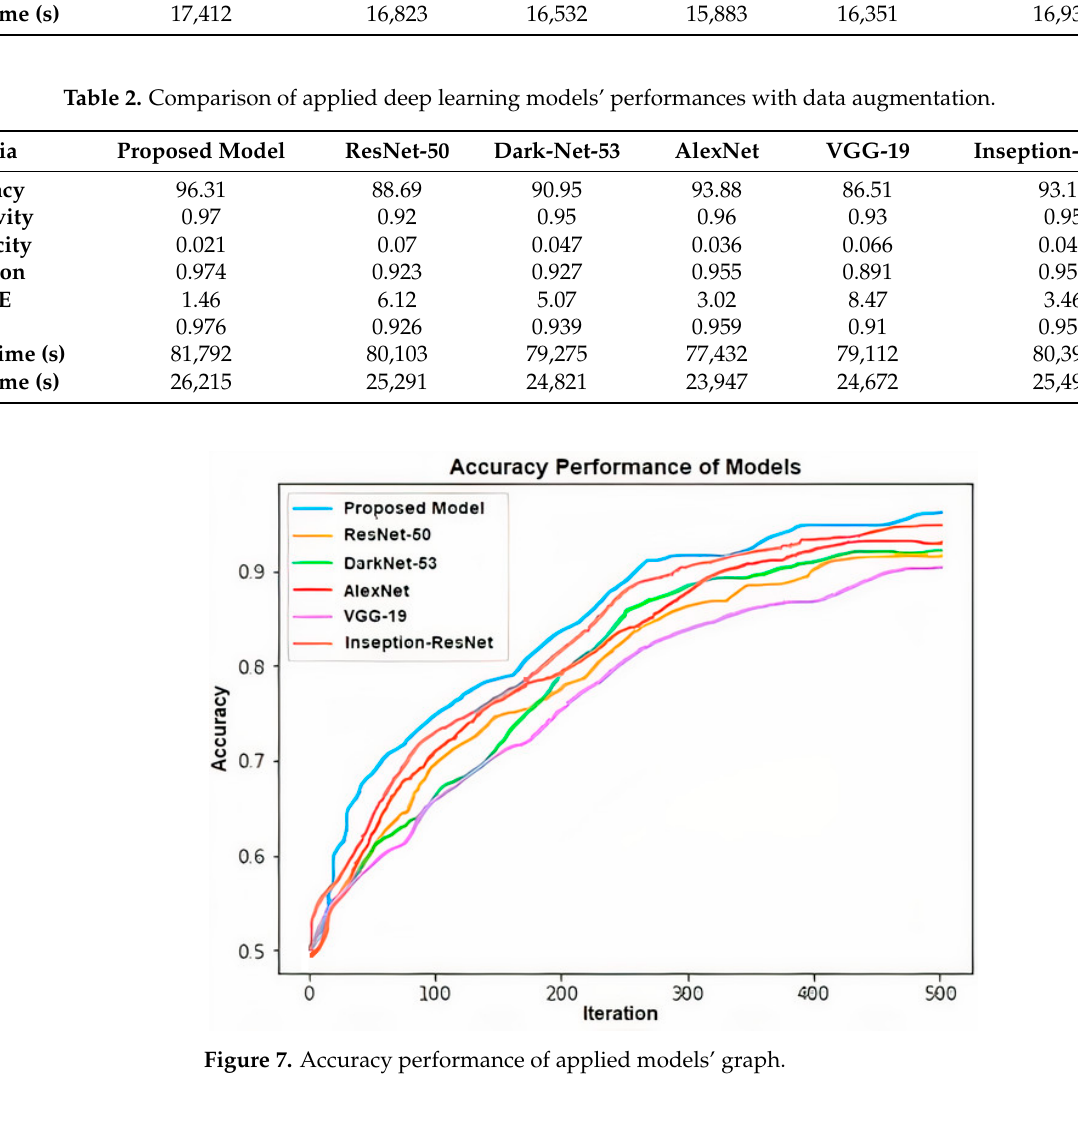
Table 1. Comparison of applied deep learning models’ performances with no data augmentation.